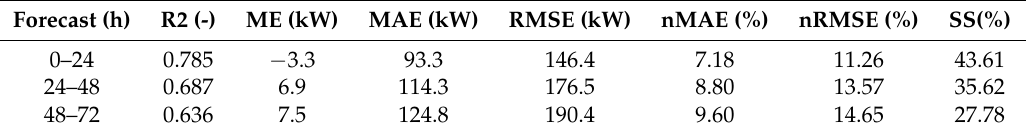
Table 4. Error measures for the deterministic forecast based on the IFS